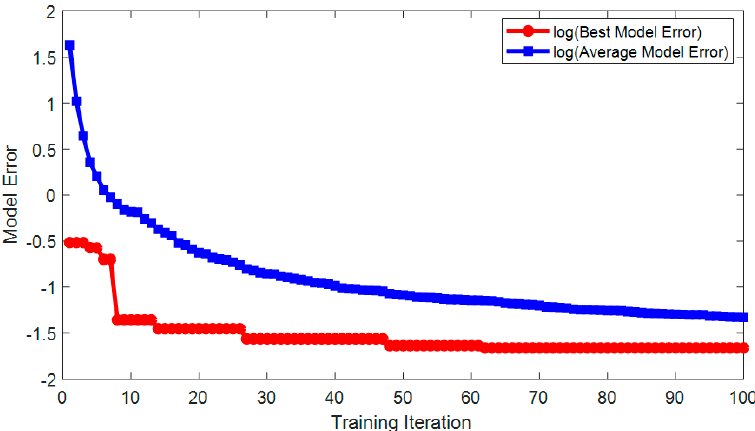
Figure 7. The optimization process of the LM-ANN approach.